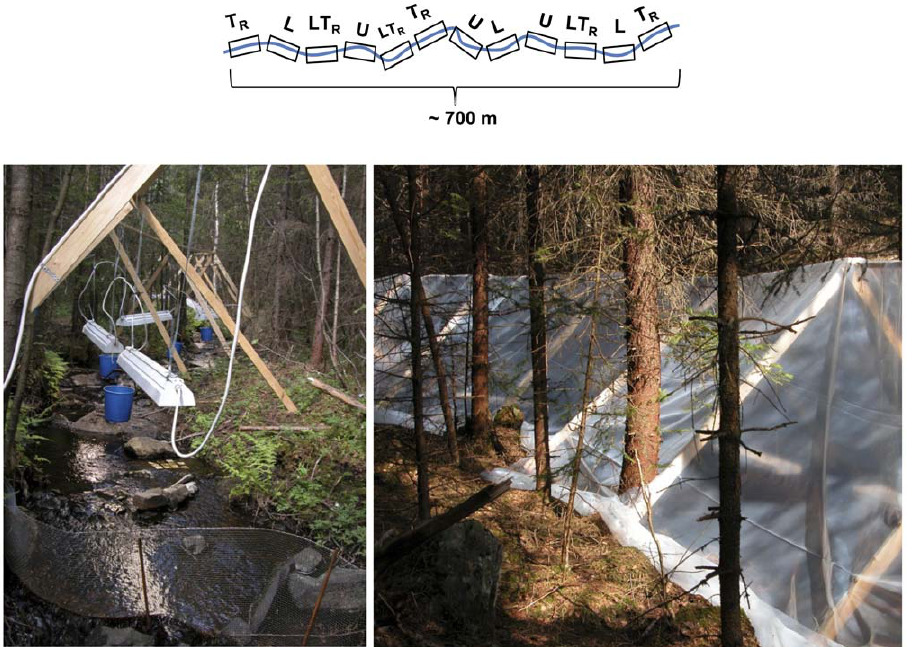
Figure 1. Illustration and photograph of the experimental area. Schematic sketch of the stream and the distribution of the four treatments (T R , L, T R L and U) and their replicates. Enclosures were 20 m long and separated from each other by a minimum of 40-m long undisturbed buffer sections. Photographs show a L and a T R